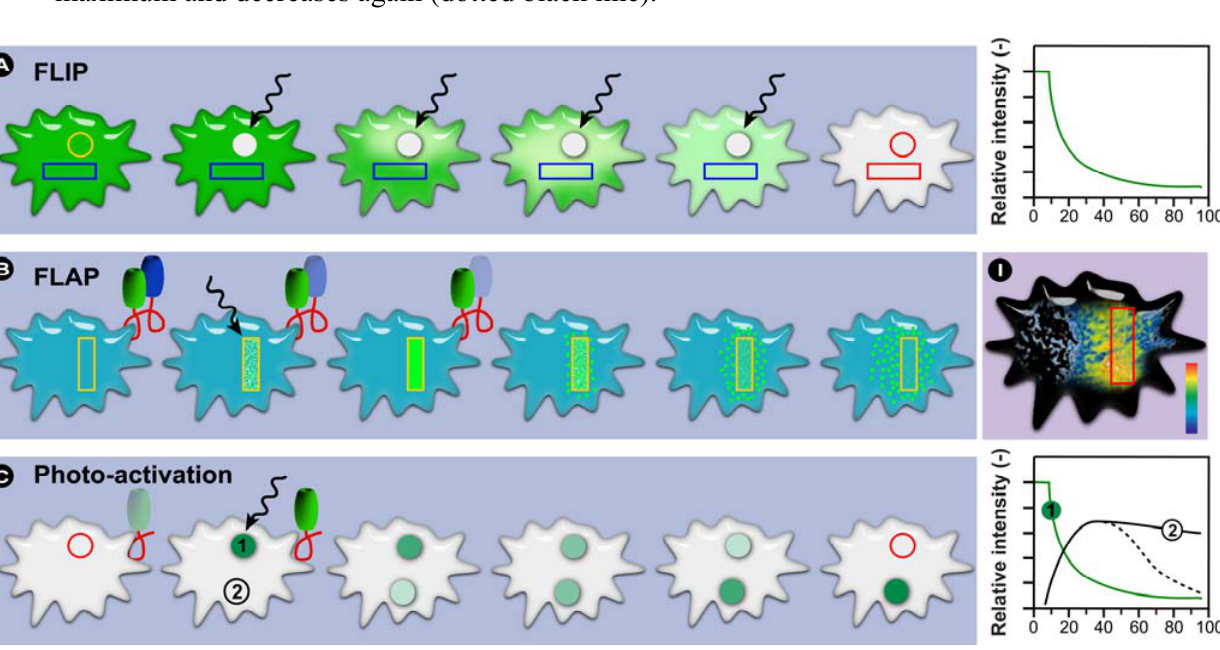
Figure 15 . Schematic representation of FLIP, FLAP, and PA experiments. ( A ) FLIP experiments involve repetitive bleaching of a selected ROI during the entire monitoring period and the fluorescence intensity in regions outside the selected bleached area is measured. The decline in fluorescence intensity in the surrounding regions is due to bleaching of fluorochromes that move through the ROI during the repetitive bleaching process. The drop in fluorescence intensity outside the bleached region is caused by a steadily increasing population of bleached, non-fluorescent molecules within the cell and thus provides quantitative data on their molecular mobility. ( B ) In FLAP, a protein is tagged with two fluorescent labels: one is photobleached and the other acts as a reference. The use of a reference fluorochrome allows the tracking of the distribution of the labeled molecules by simple image differencing ( I ) and thus enables measurement of fast relocation dynamics. ( C ) In photo-activation (PA), the passive fluorochrome (non- fluorescent) is activated with an appropriate wavelength, which removes any quenchers or realigns bonds so that the active chromophore is formed. The loss in fluorescence in compartment 1 and gain in 2 are monitored simultaneously, which provides information on protein dynamics and compartment interconnectivity. Note that when the fluorochrome moves from 1 to 2 and subsequently diffuses out of that compartment, the curve reaches a maximum and decreases again (dotted black